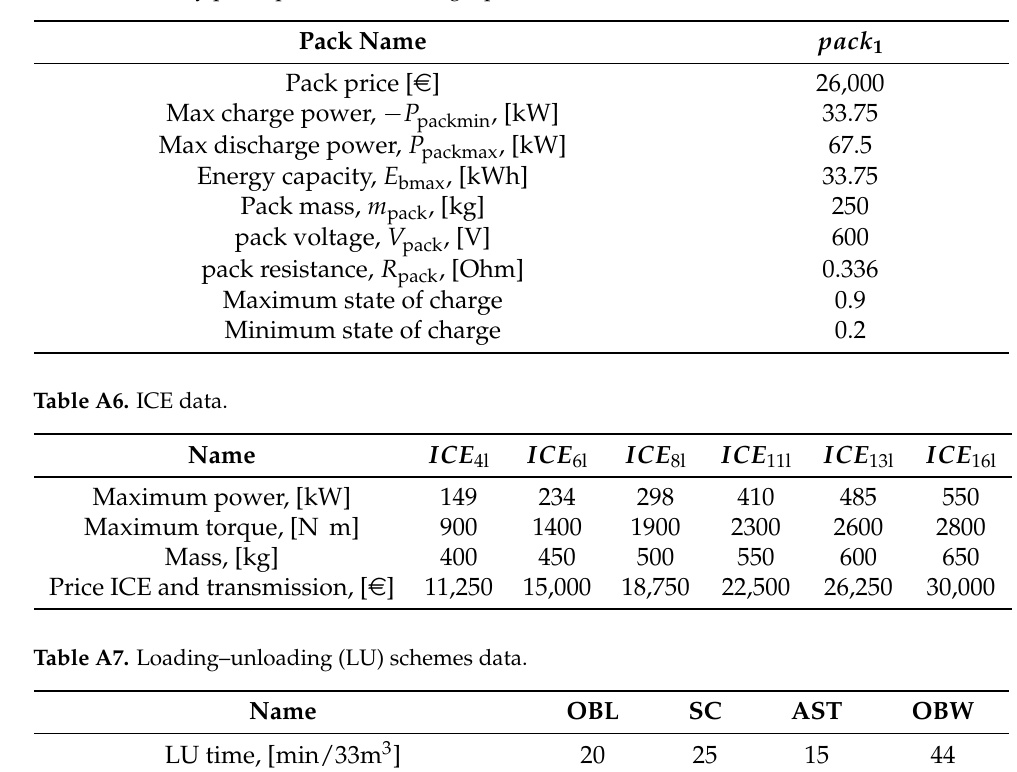
Table A5. Battery pack specification (a single pack).